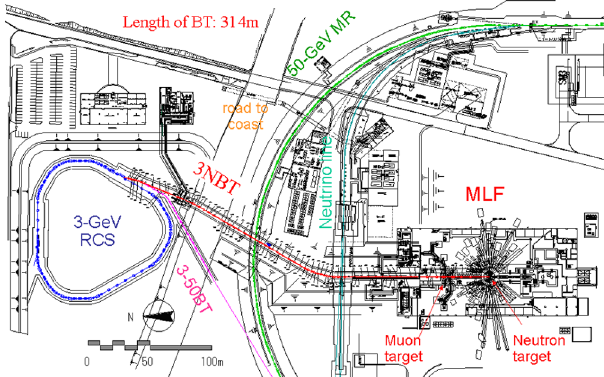
FIG. 7. Integral beam intensity to total at outside of 6 σ